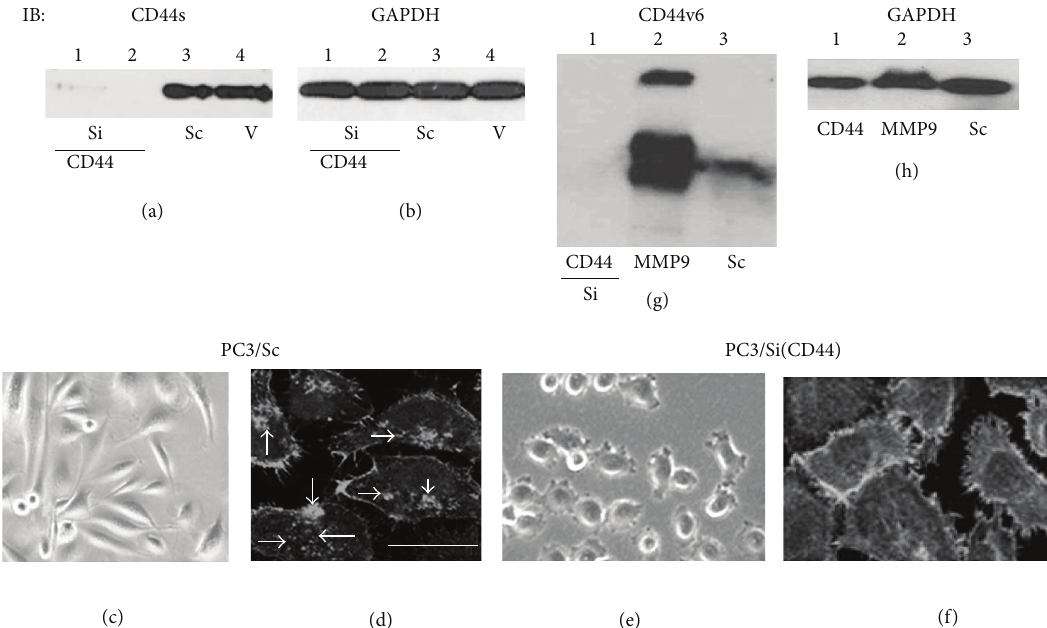
Figure 6: Analysis of the effects of CD44 knockdown on the expression of CD44v6, cell morphology, and actin distribution. (a), (b), (g), and (h) The effect of ShRNA to CD44 on the cellular levels of CD44s protein was determined by immunoblotting analysis. The expression levels of CD44s are shown in different PC3 cell lines by immunoblotting analysis (a). Individual clones were isolated from cells transfected with a construct corresponding to 492 bp ((a), lane 1) and 801bp (lane 2). Cells transfected with a nonsilencing scrambled ShRNA construct (Sc; lane 3) and vector DNA (V; lane 4) were used as controls. PC3 cells knockdown of CD44s ((g), lane 1) and MMP9 (lane 2) as well as a control PC3/Sc cells (lane 3) were used for immunoblotting analysis with an antibody to CD44v6. Total cellular lysates ( ∼ 50 𝜇 g) were used for immunoblotting analyses (a), (b), (g), and (h). Equal loading of protein was verified by immunoblotting with an antibody GAPDH (b) and (h). The experiment was repeated three times with similar results. (c)–(f) The morphology of PC3/Sc and PC3/Si (CD44) cells was determined by phase contrast microscopy (400x; (c) and (e)). Cells were stained with rhodamine phalloidin to examine the distribution of actin in PC3/Sc (d) and PC3/Si (CD44) (f) cells. Staining of actin is shown in gray scale (d) and (f). Arrows point to invadopodia in PC3/Sc cells (d). The results shown are representative of three independent experiments. Bar: 50 𝜇